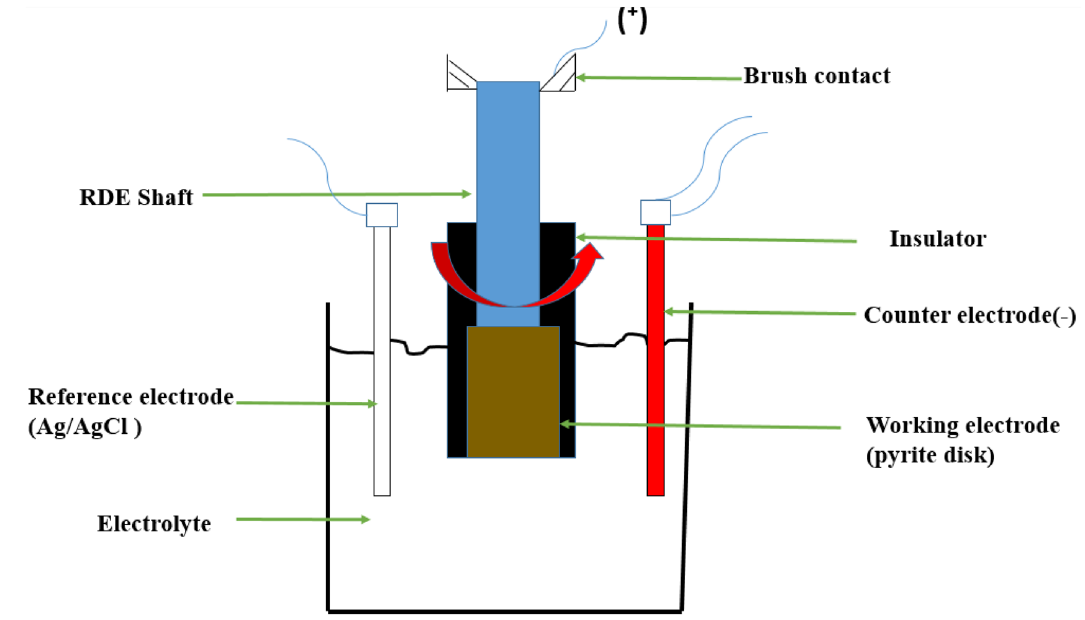
Figure 2. Schematic of the 3-electrode system used in this study.